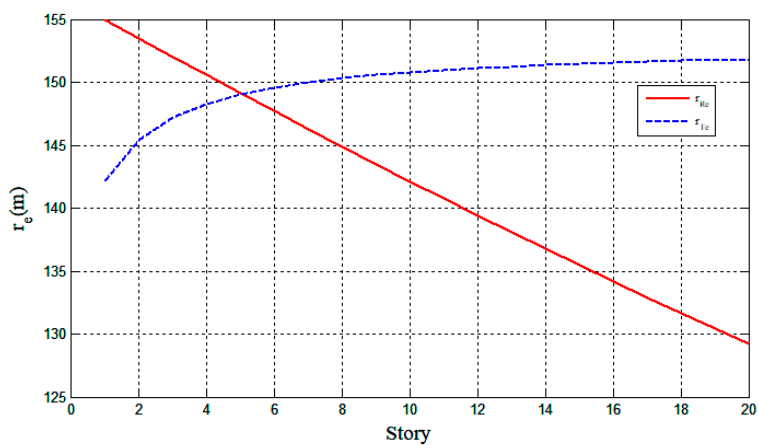
Figure 11. Equivalent radii of different stories’ frame structures equipped with SLDTFPB and SLDRFPB.